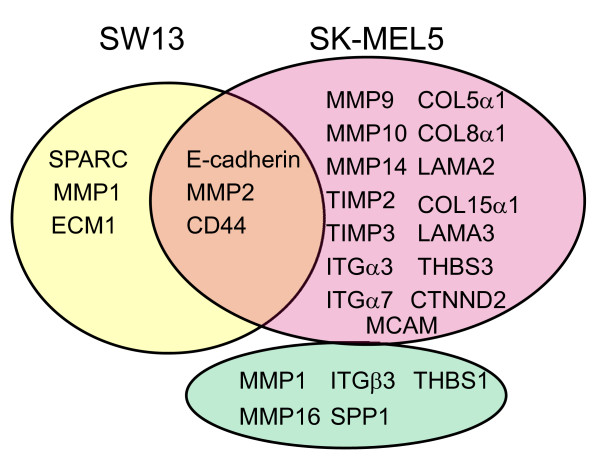
Comparison of extracellular matrix and adhesion molecule regulation by BRG1 in SW13 and SK-MEL5 cells. Venn diagram showing genes up-regulated by BRG1 in SW13 cells (yellow), genes up-regulated by BRG1 in SK-MEL5 cells (red), and genes down-regulated by BRG1 in SK-MEL5 cells (green). Three genes were activated by BRG1 in both SWI3 and SK-MEL5 cells (orange). Only genes that were assayed in both SK-MEL5 cells (present study) and SW13 cells [28,29,76] are shown.